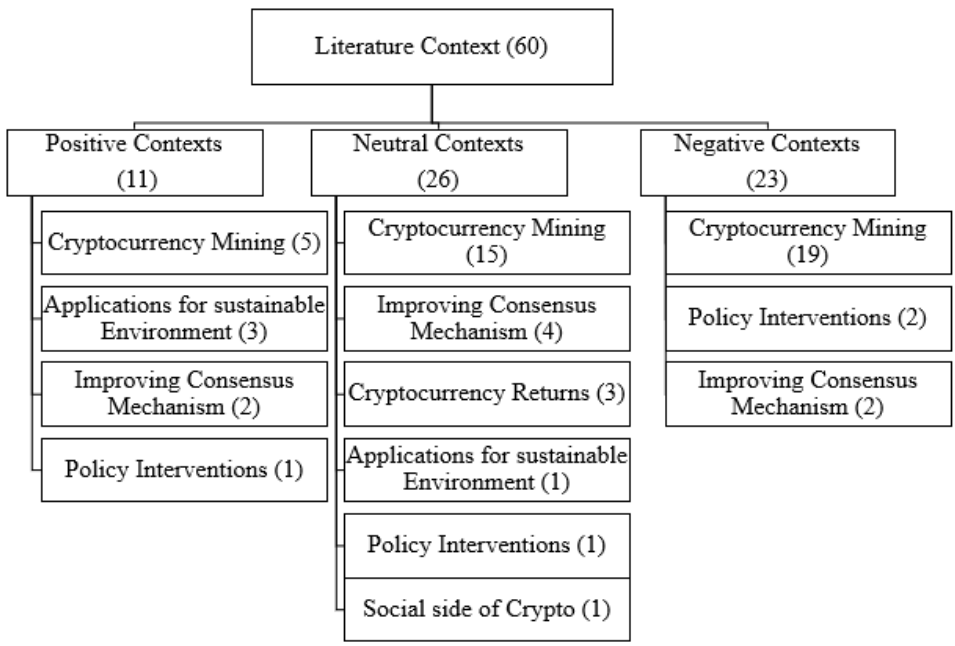
Figure 6. Theme-Based